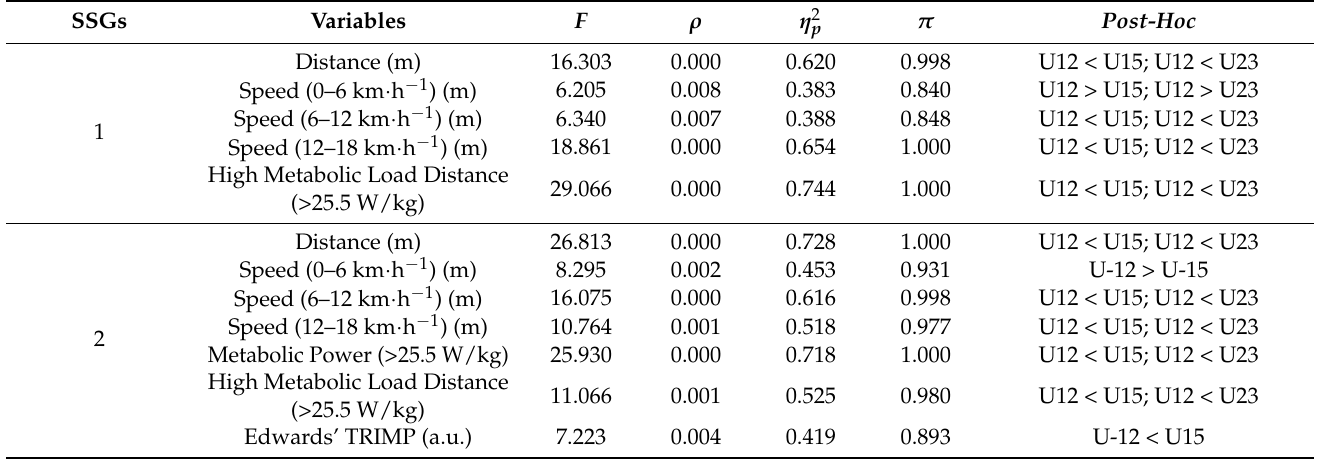
Table 2. Differences between age categories in different small-sided soccer